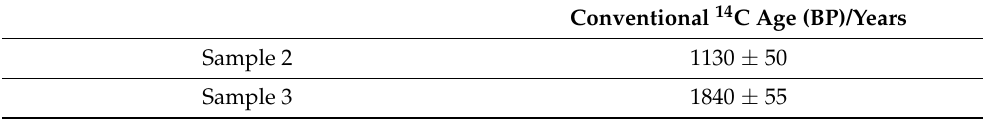
Table 1. Age of tested subfossil samples .